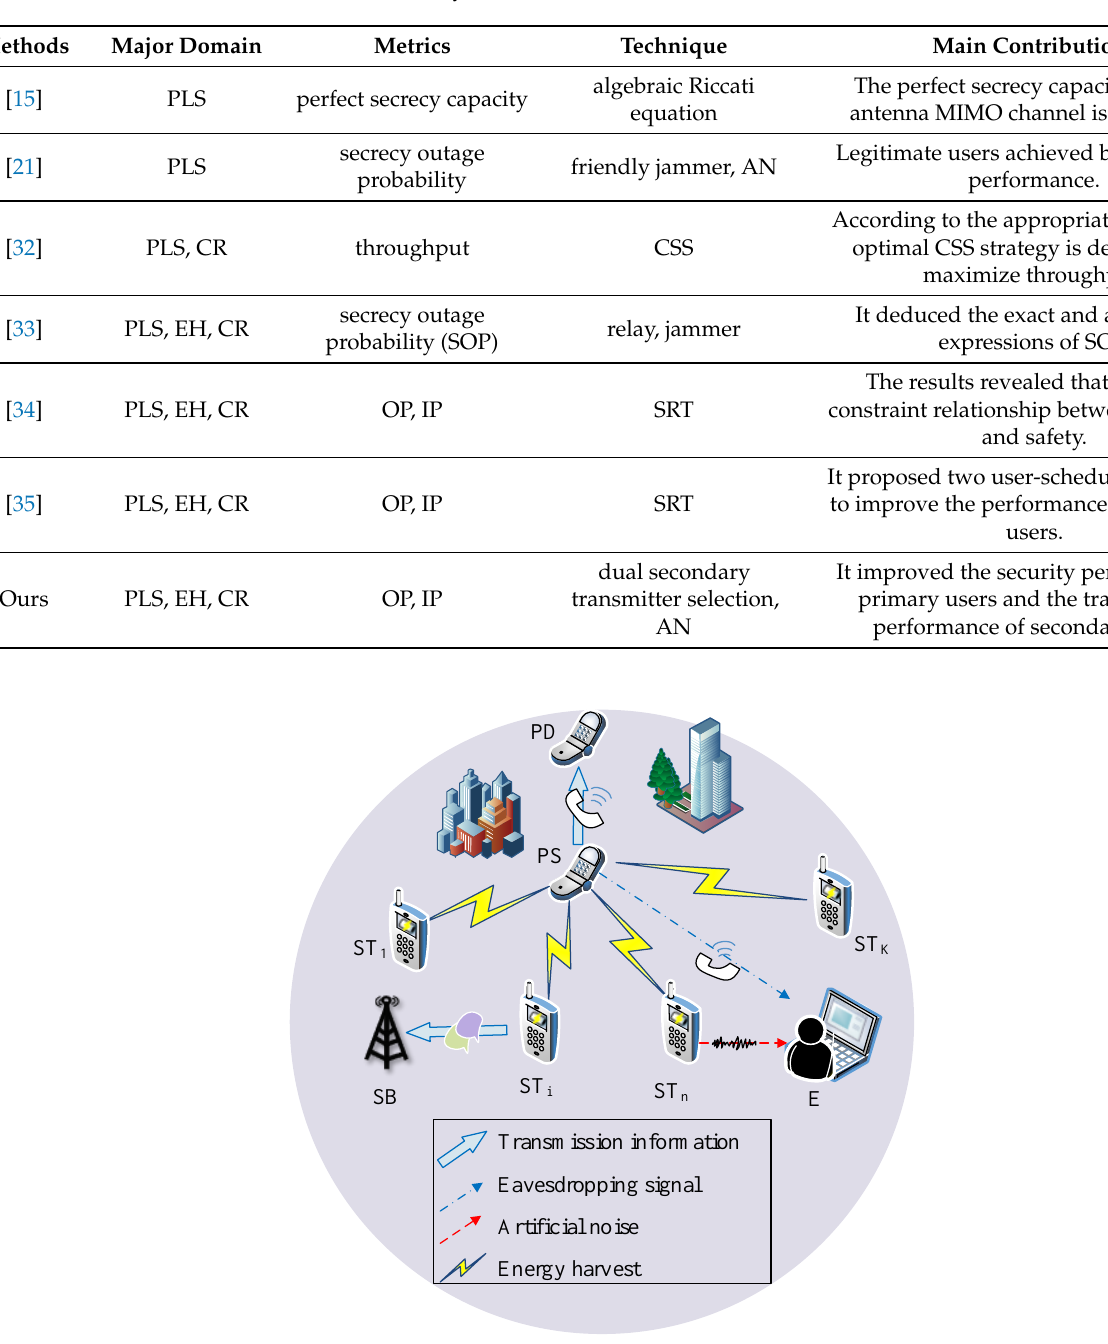
Table 1. Summary of some related works.